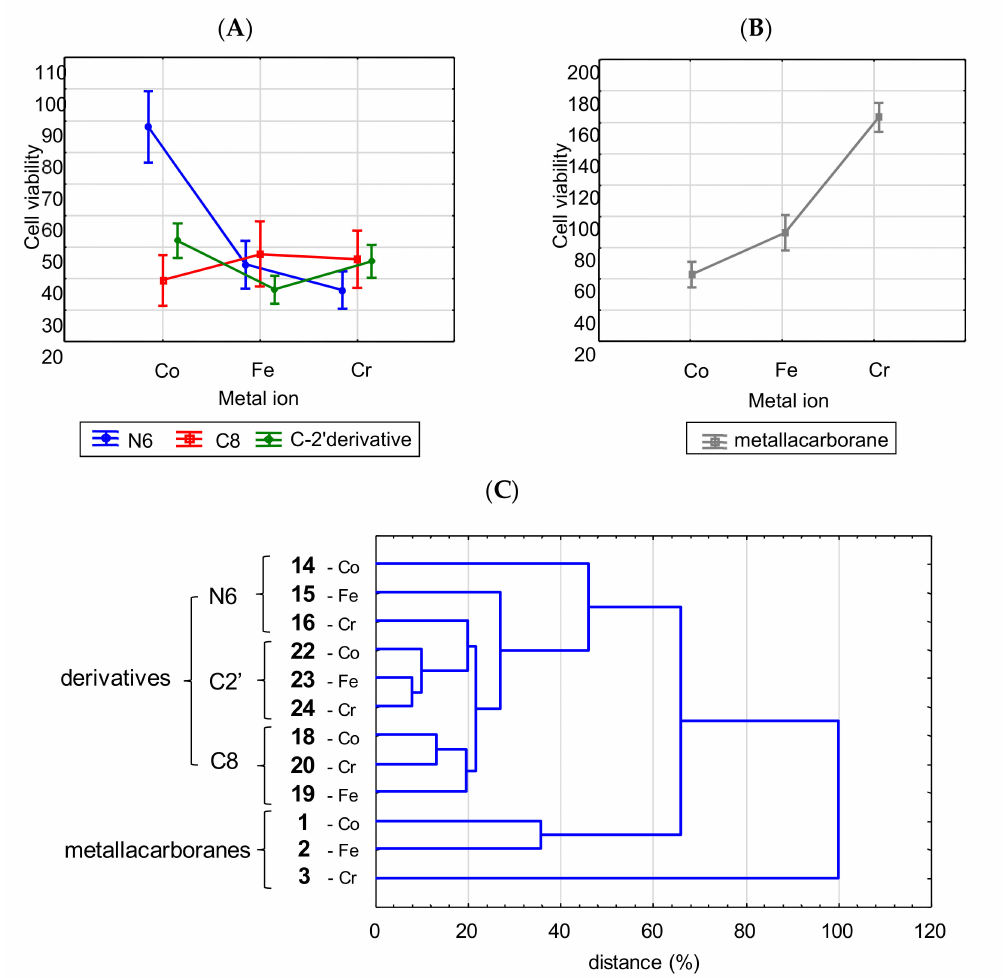
Figure 3. Activity of adenosine derivatives modified with metallacarboranes in relation to metal type and substitution site ( A ); ( B ) the significance of metal ion for the activity of unmodified metalla bis(dicarbollide) ions. Data were weighted arithmetic averages ± CI 0.95 calculated for a given compound (IC50, µ M) across the cancer cell lines (factor analysis). In the case of the unmodified metalla bis(dicarbollide) ions and the N 6 derivative with Co ion (compound 14 ), the dependence between cytotoxicity and type of metal is clearly visible. Contrary to the latter, the diversity of activity of the remaining derivatives was not as spectacular, although significant ( p < 0.05, Co- or Cr- versus Fe-derivatives). ( C ) The result of cluster analysis of twelve compounds, based on their toxicity against ovarian cancer cells. Compounds 14 – 16 , 18 – 20 , and 22 – 24 are adenine nucleosides modified at the N 6 , C2 (cid:48) , and C8 positions with Co-, Fe-, and Cr-containing bis(dicarbollide) ions; compounds 1 – 3 are unmodified parent cages; unweighted pair-group method with arithmetic mean (UPGMA), Euclidean